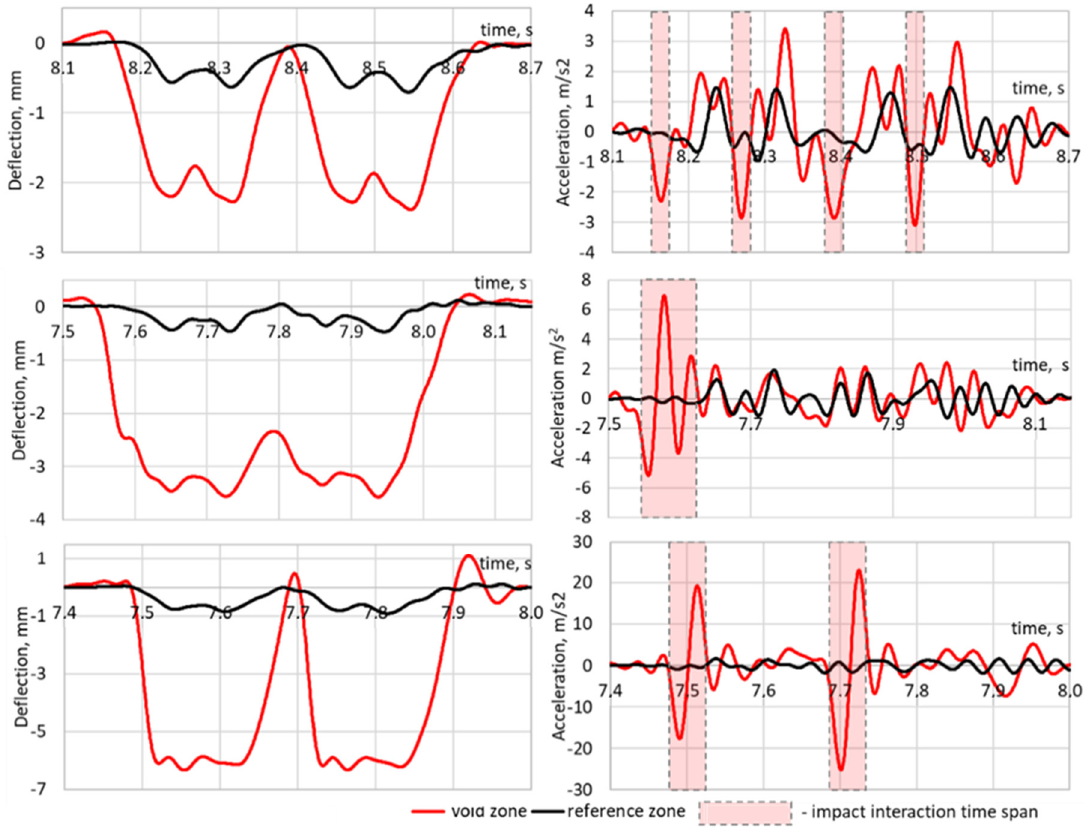
Figure 14. Measured rail deflections ( left column ) and the derived accelerations ( right column ) for different void damages: ( top )—ICE1 110 km/h, ( middle )—RBDe560 109 km/h, ( bottom )—RABDe500—164 km/h.